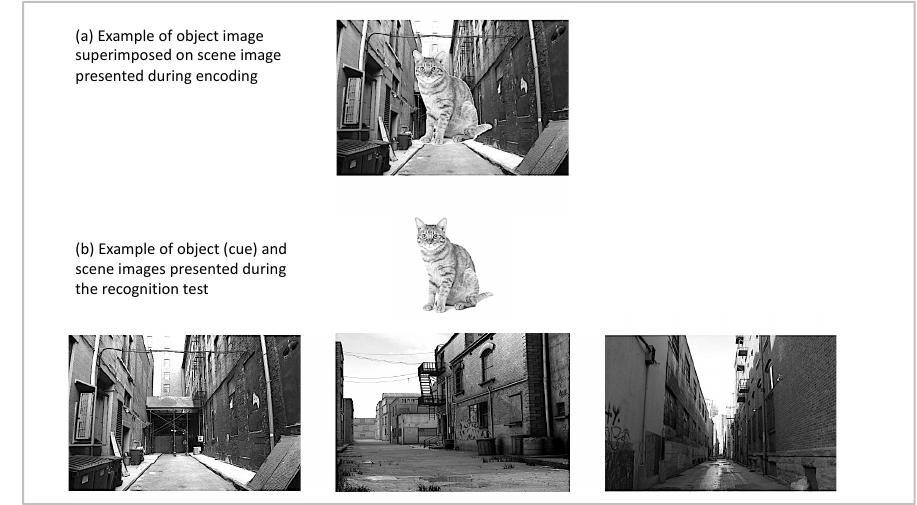
Figure 1. Examples for stimuli used during encoding ( a ) and test ( b ). Stimuli were presented in color in the study.